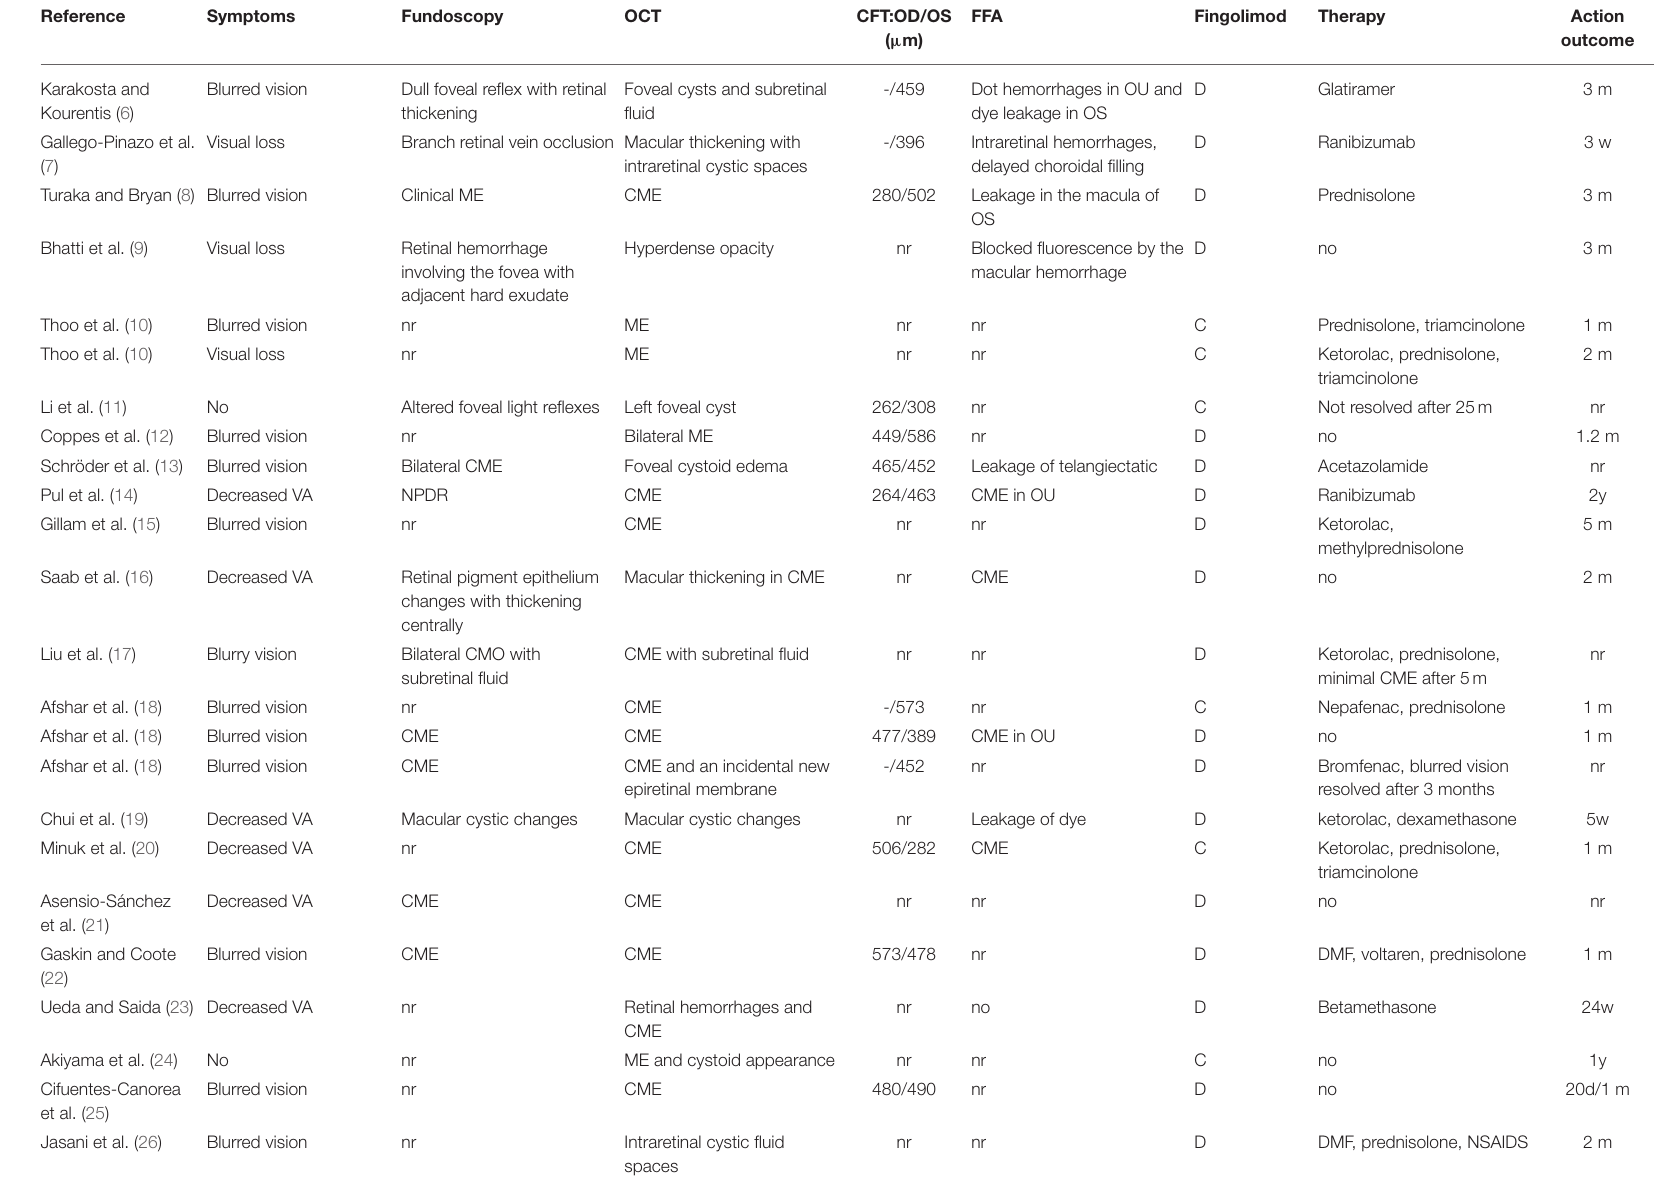
TABLE 2 | Clinical manifestations, ophthalmic examination, treatment, and prognosis of 41 included